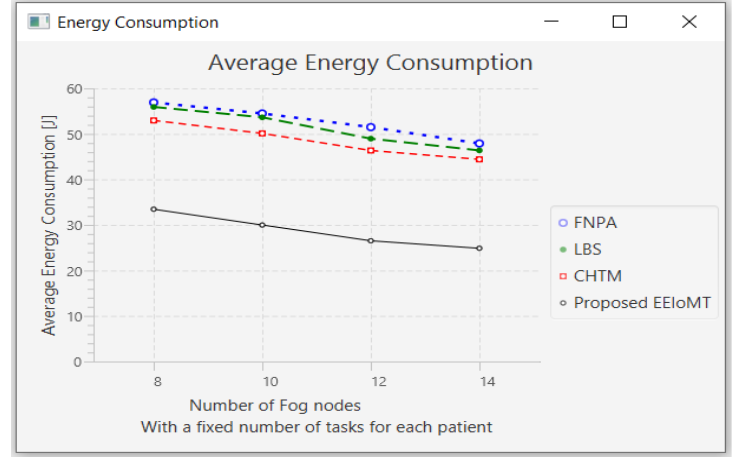
Figure 13. Average energy consumption comparison when changing the number of fog nodes.